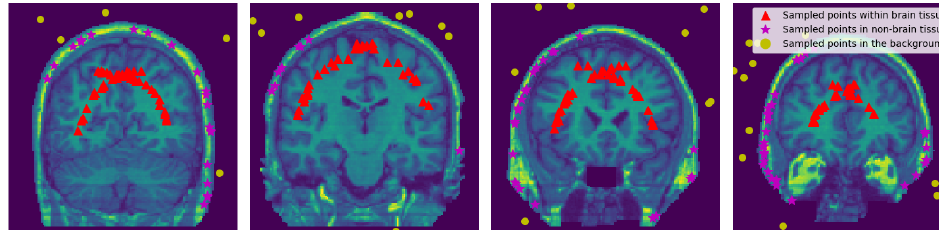
Figure 4. Sampled Points: 2D visualization of the representative coronal section from MRI image of a single subject (OASIS data) showing the sampled points within the brain, within the non-brain, and in the background region. δ 1 and δ 2 values were set to 15 and 3, respectively.